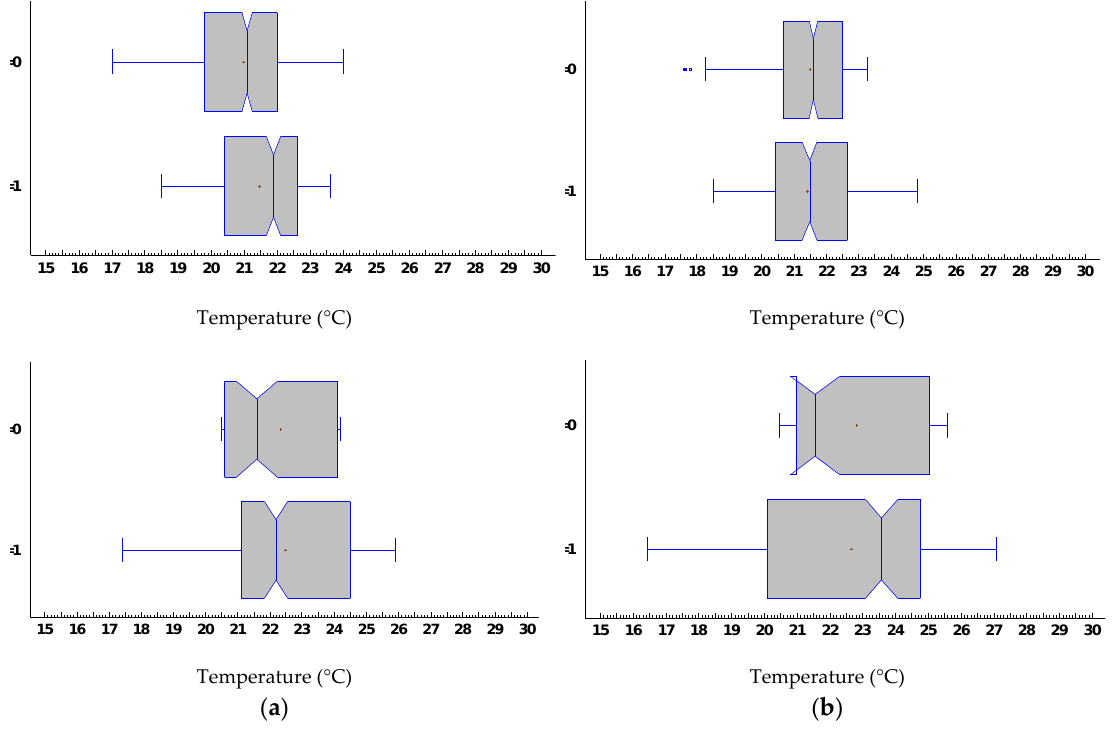
Figure 4. Quartile distribution for indoor air temperature and operative temperature. ( a ) Quartile distribution for indoor air temperature; (T o ) winter (top) and mid-season (down) with windows closed (0) and open (1). ( b ) Quartile distribution for operative temperature (T o ); winter (top) and mid-season (down) with windows closed (0) and open (1).